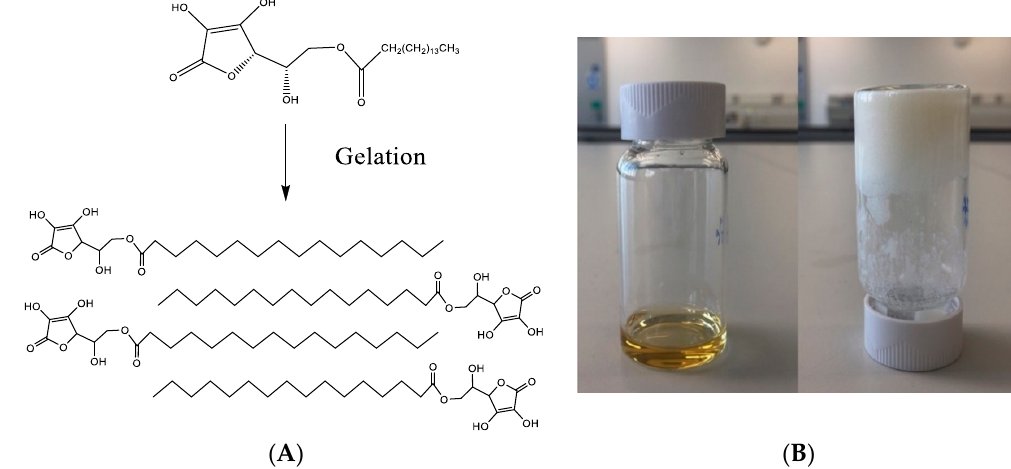
Figure 1. Formation of ascorbyl palmitate (AP) hydrogel. ( A ) Molecular structure of AP and the assembled hydrogel, highlighting the central alignment of the hydrophobic portion and the hydrophilic heads on the outside of the bilayer (adapted from Zhang et al. [9]). ( B ) AP dissolved in dimethyl sulfoxide (left) and addition of water to this solution resulting in hydrogel (right).